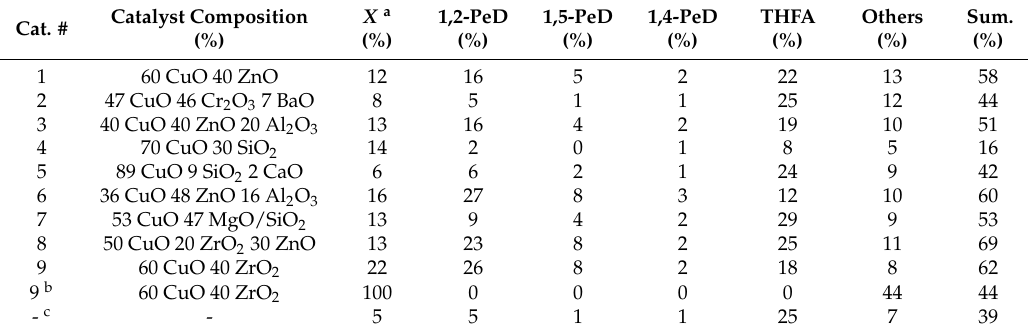
Table 1. Overview of the selectivity and conversion of different commercial copper catalysts after 6 h reaction time.